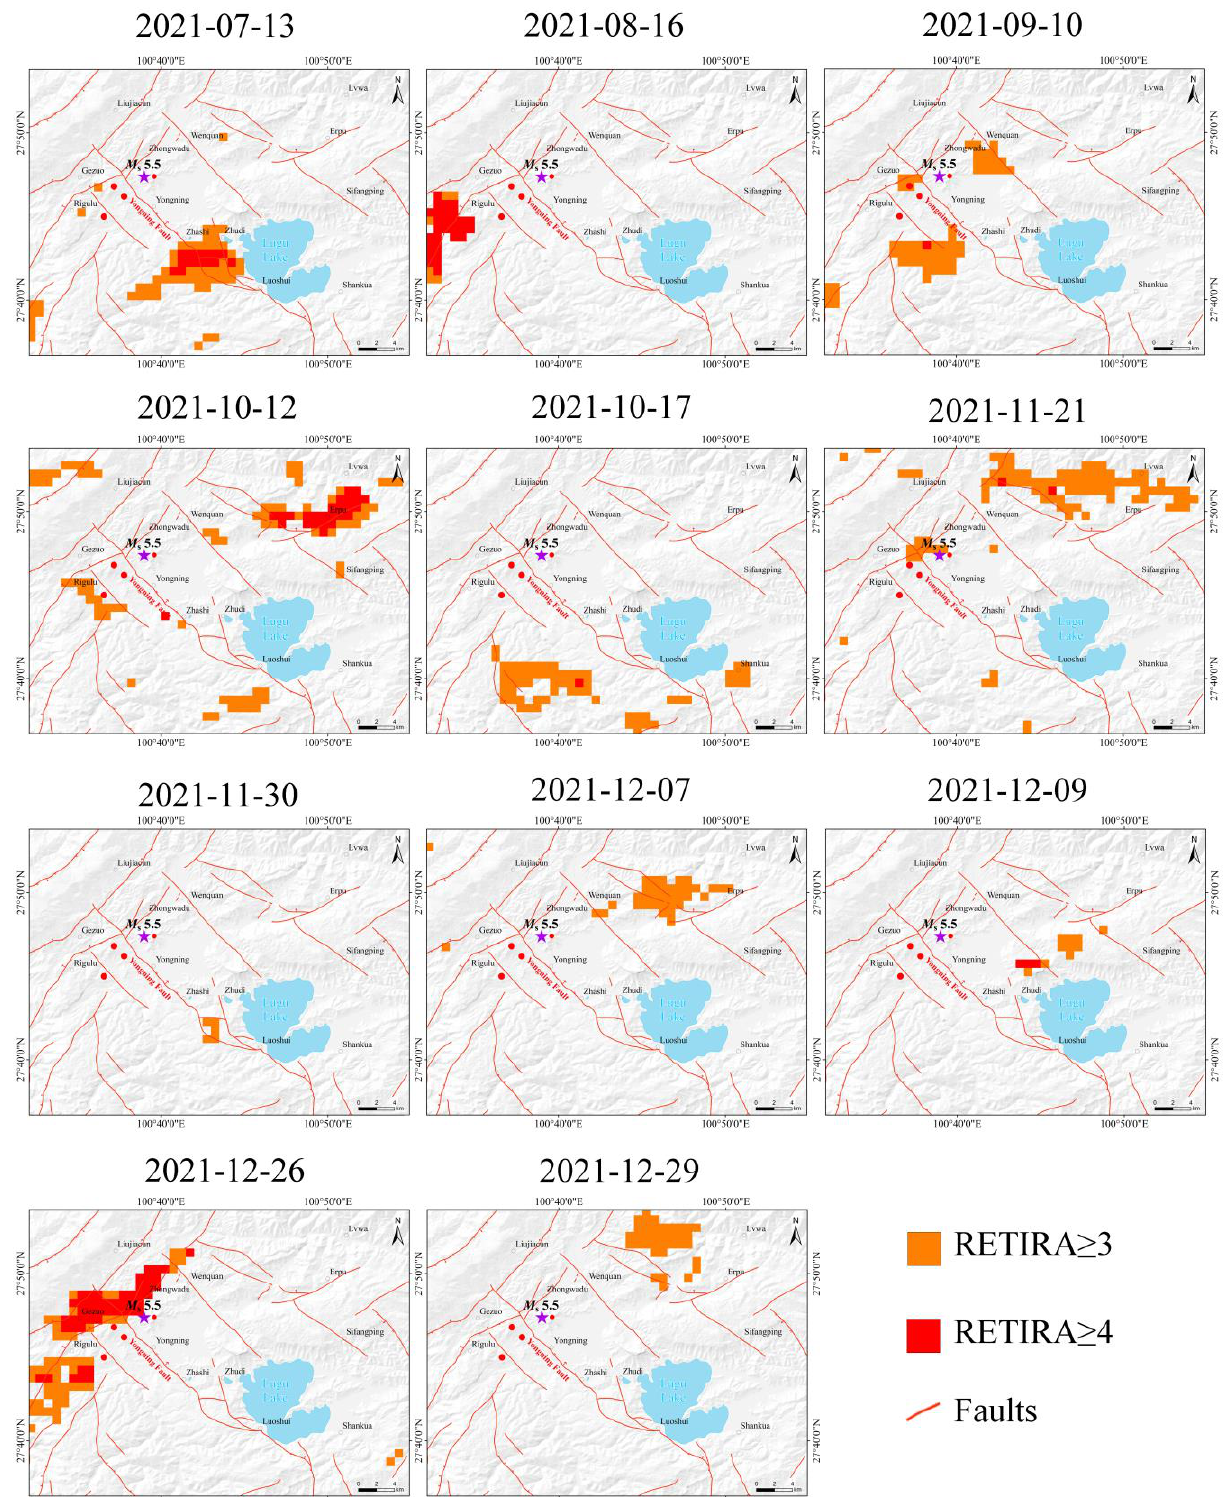
Figure 10. The RETIRA thermal anomalies before the M s 5.5 earthquake on 2 January 2022. The purple star and red circles are the epicenters in January and April, respectively.